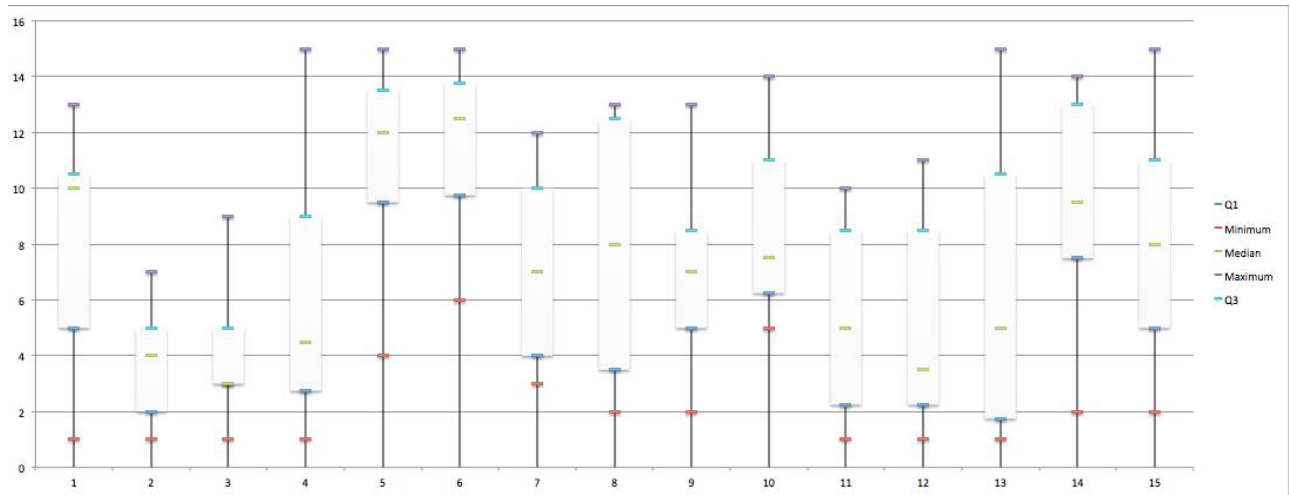
Figure 3. Results of A4 providedas part of